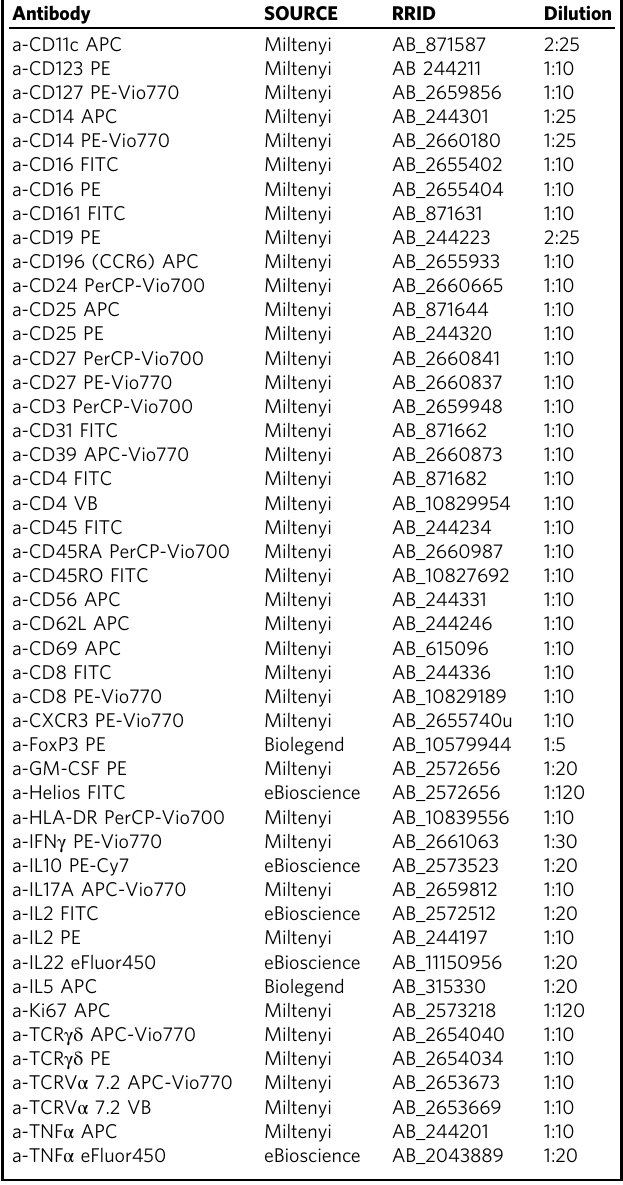
Table 2 Antibodies used for the fl ow cytometry